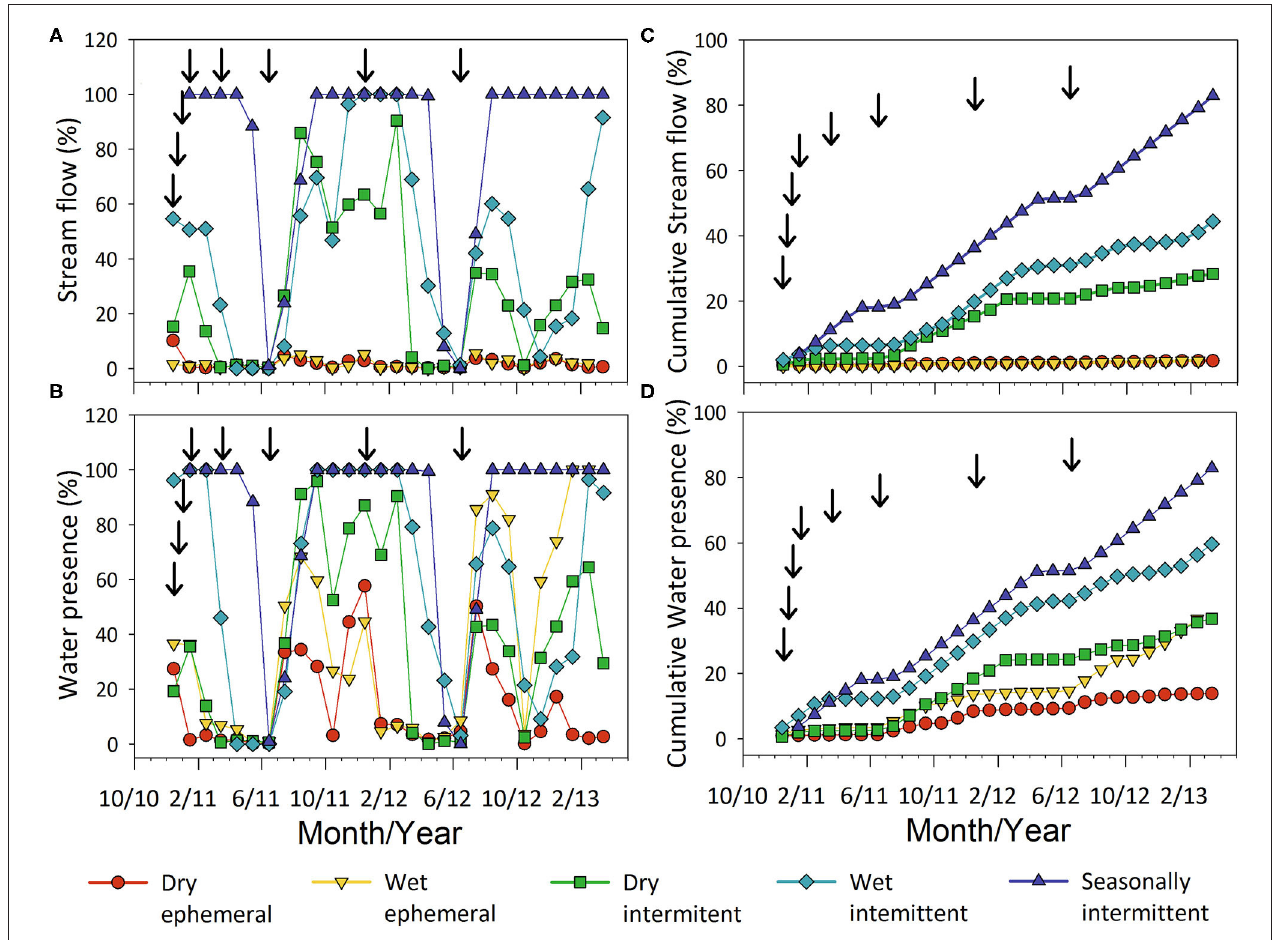
FIGURE 3 | Monthly percent of sites with streamflow and stream water presence at dry-ephemeral (BG, SW, HP, GP), wetephemeral (RP, RL), dry-intermittent (HU, GL), wet-intermittent (HL, GU), seasonally-intermittent (RU) locations. Mean monthly values for each flow regime category are shown in (A,B) . Arrows indicate litterbag collections. Cumulative streamflow and water presence percentages as a fraction of the total days over a monitoring periods are show in (C,D)